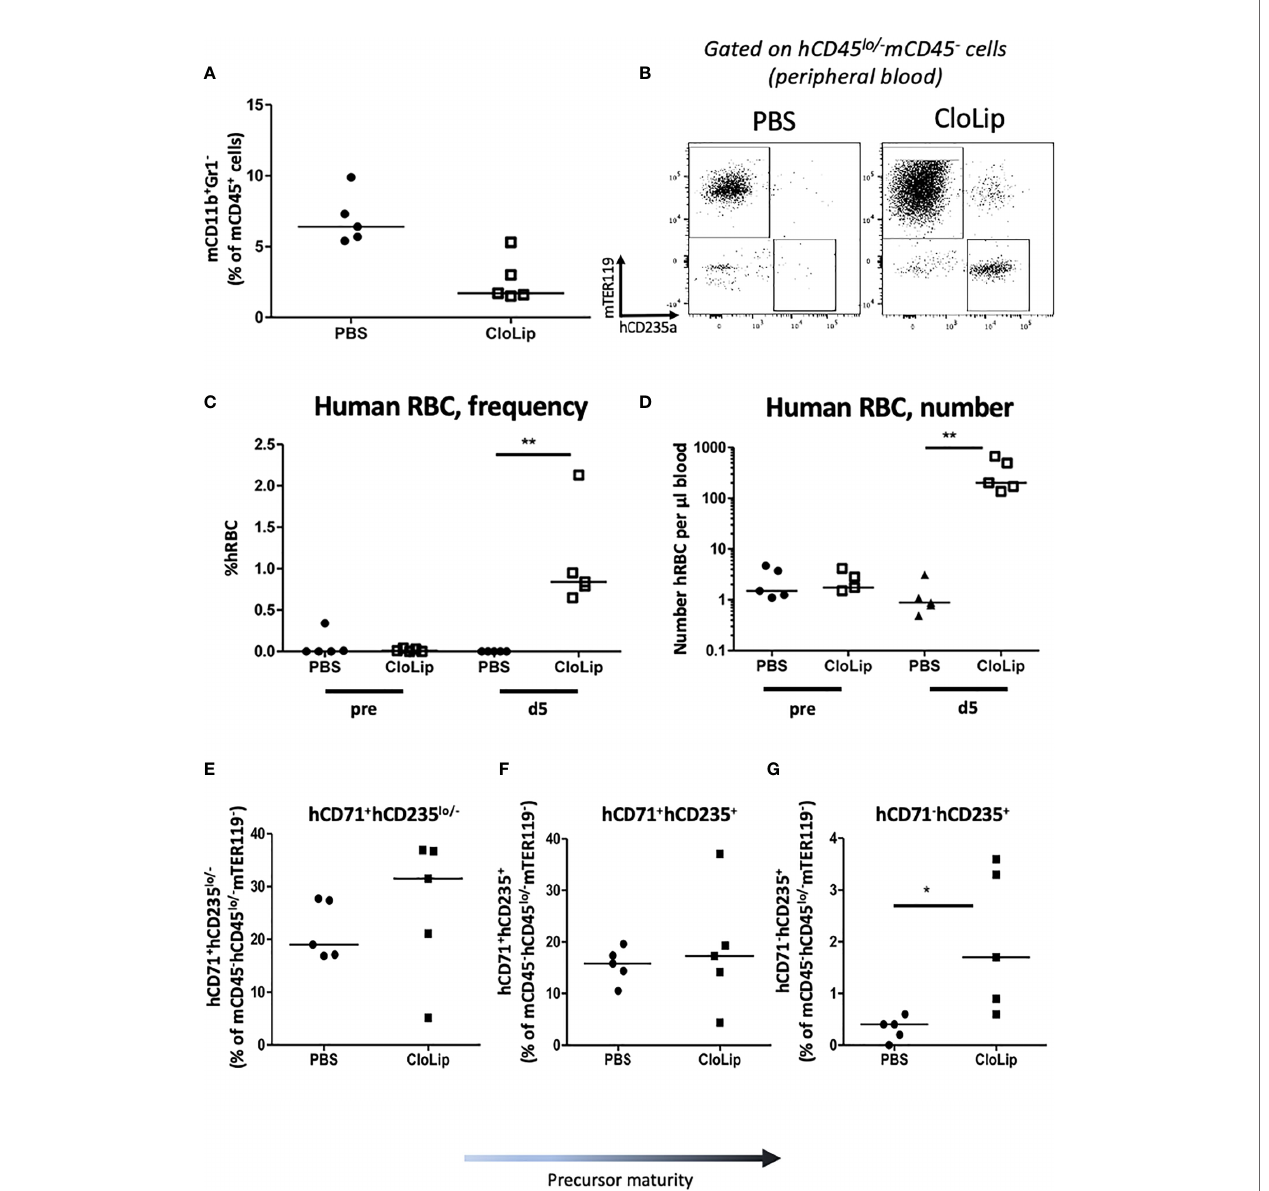
FIGURE 8 | Effect of murine phagocyte clearance on human erythrocyte reconstitution HSPC-NBSGW mice. (A – G) HSPC-NBSGW mice injected with 50x10 3 hUCB CD34 + cells 11 weeks earlier were injected with clodronate liposomes (CloLip) or PBS (control) and analyzed over 6 days. (A) Frequency of mouse CD11b + Gr1 - cells in the blood 5 days after clodronate liposome (CloLip) treatment. (B) Representative fl ow cytometric analysis of human CD235 + RBCs in the blood 5 days after CloLip treatment. (C) frequency and (D) absolute number of human RBCs (hCD235 + ) in the peripheral blood 5 days after CloLip treatment. (E) Frequencies of hCD71 + hCD235 -/lo , (F) hCD71 + hCD235 + and (G) hCD71 - hCD235 + in the bone marrow (BM) 6 days after CloLip/PBS treatment. Symbols represent individual mice. Bars represent median values (A) – (C – G) ; Statistical signi fi cance was assessed using the Mann Whitney test (*p<0.05,